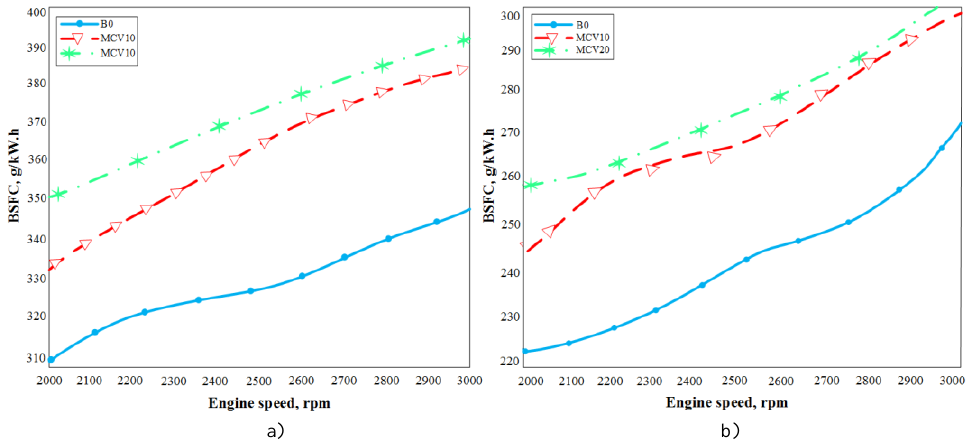
Fig. 10. BSFC of MCV biodiesel blends at half-load (a) and full-load (b).